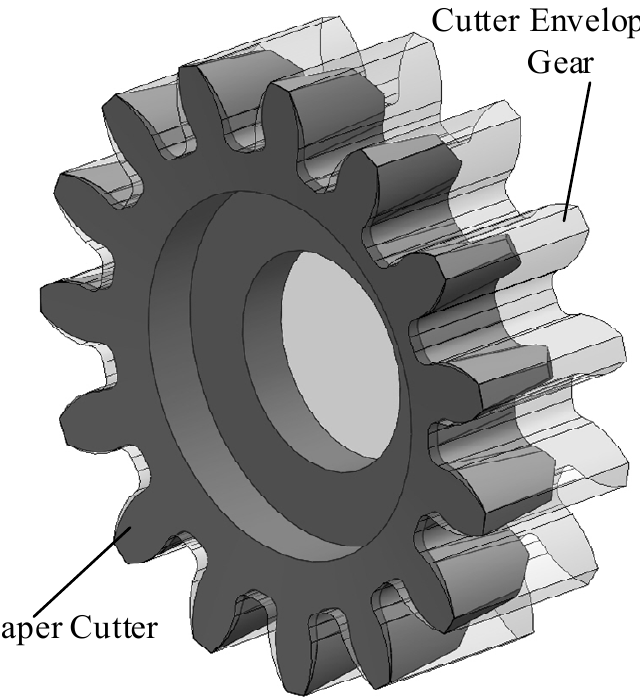
Figure 6. Spur shaping cutter and cutter enveloping gear.